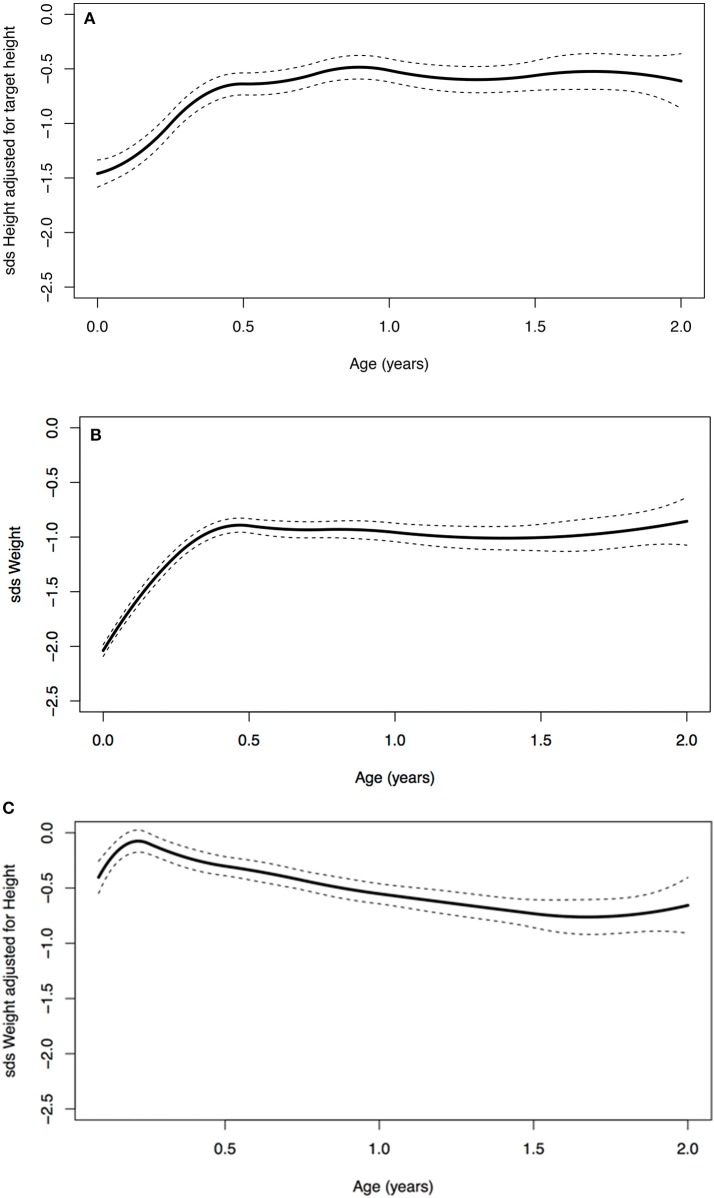
(A) Age vs. standard deviation score (SDS) height adjusted for target height, (B) SDS weight, and (C) SDS weight for height.